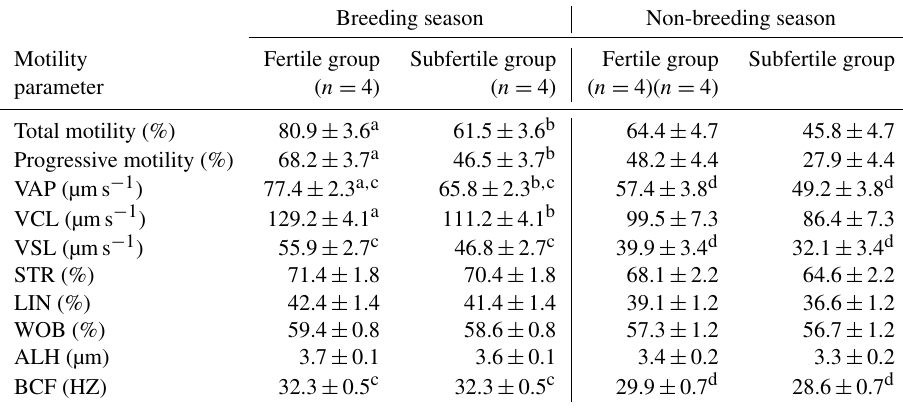
Table 3. CASA-derived sperm motility parameters of chilled semen collected from fertile and subfertile stallions during breeding and non- breeding season (least-square means ±